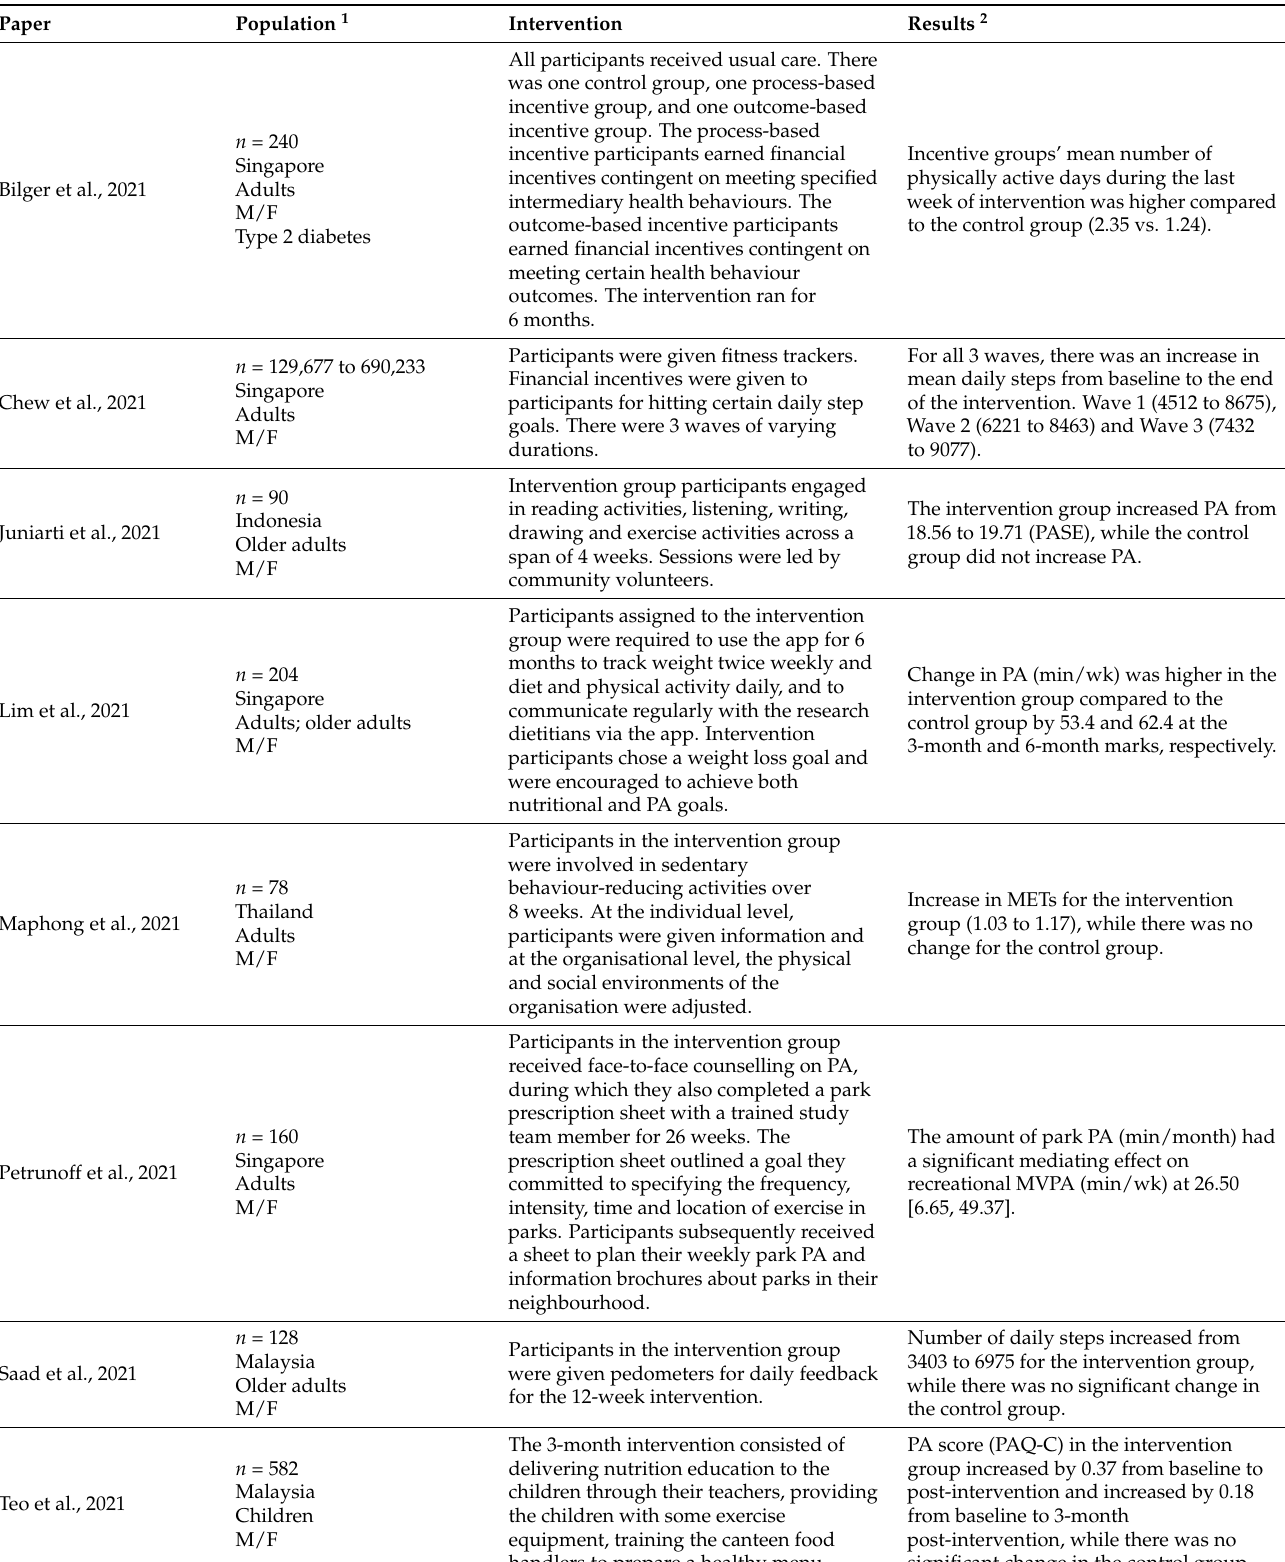
Table 2. Breakdown of study characteristics, interventions and findings for all studies included in the